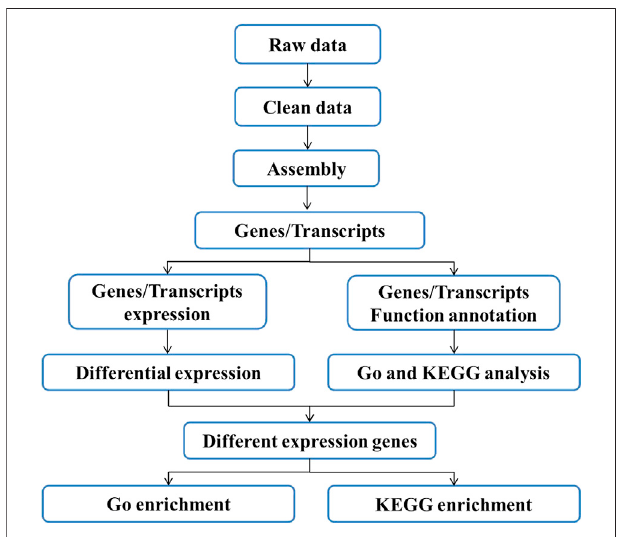
FIGURE 1 | Detailed schematic diagram of the bioinformatics